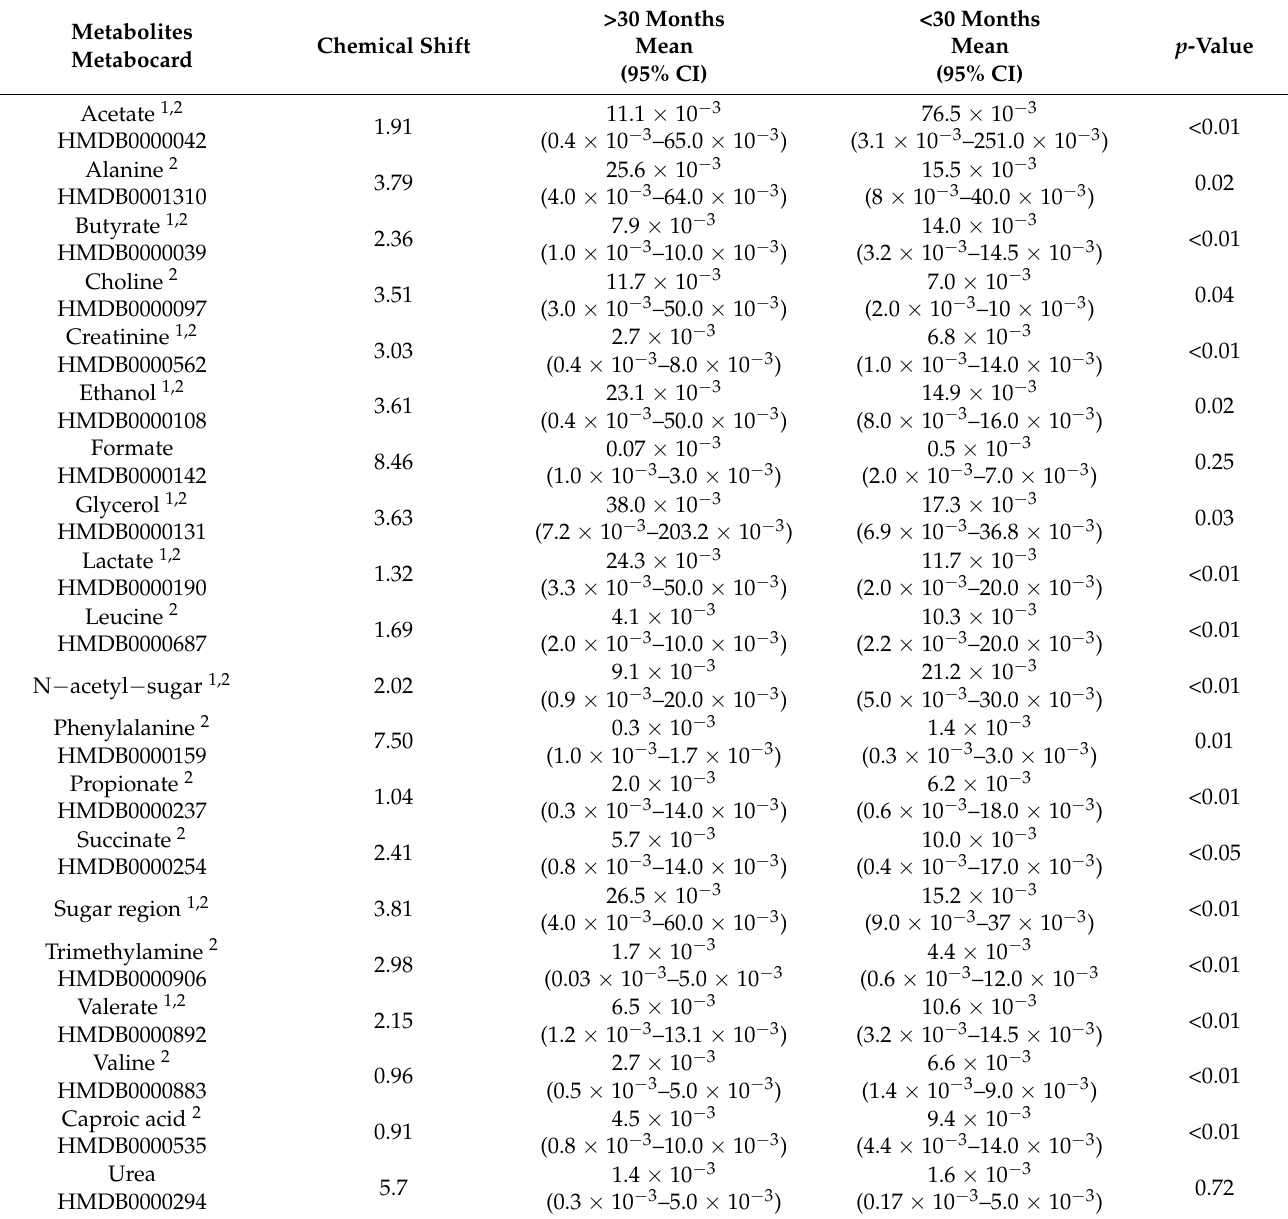
Table 1. Metabolites that differ between groups: < vs. >30 months of